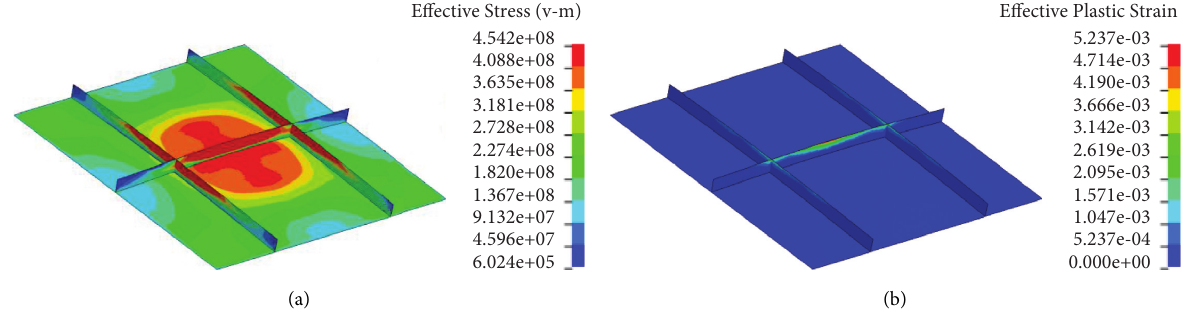
Figure 12: (a) von Mises stress and (b) effective plastic strain of the RFBD5.